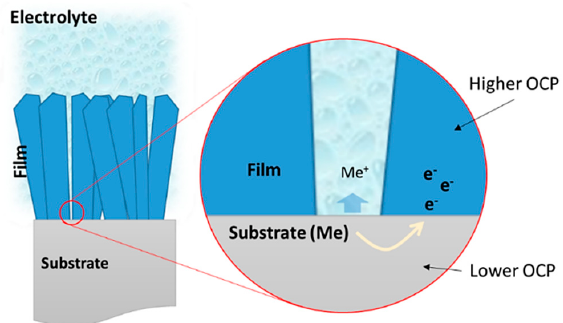
Figure 3. Scheme of galvanic corrosion through the defect promoted by the higher open circuit potential (OCP) of the film compared to that of the substrate. (OCP) of the film compared to that of the